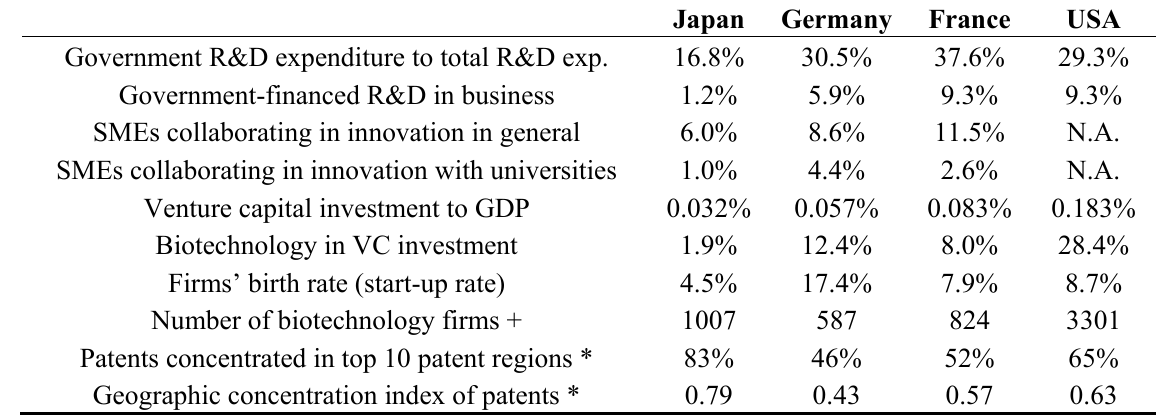
Table 1. International Comparison of Basic Conditions for Regional